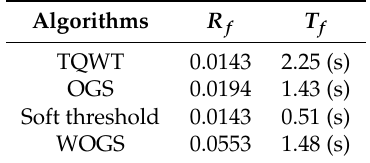
Figure 16. Results of soft threshold: ( a ) Time-domain waveform. ( b ) Envelope spectrum. Table 3. Comparison of R f and T f of four